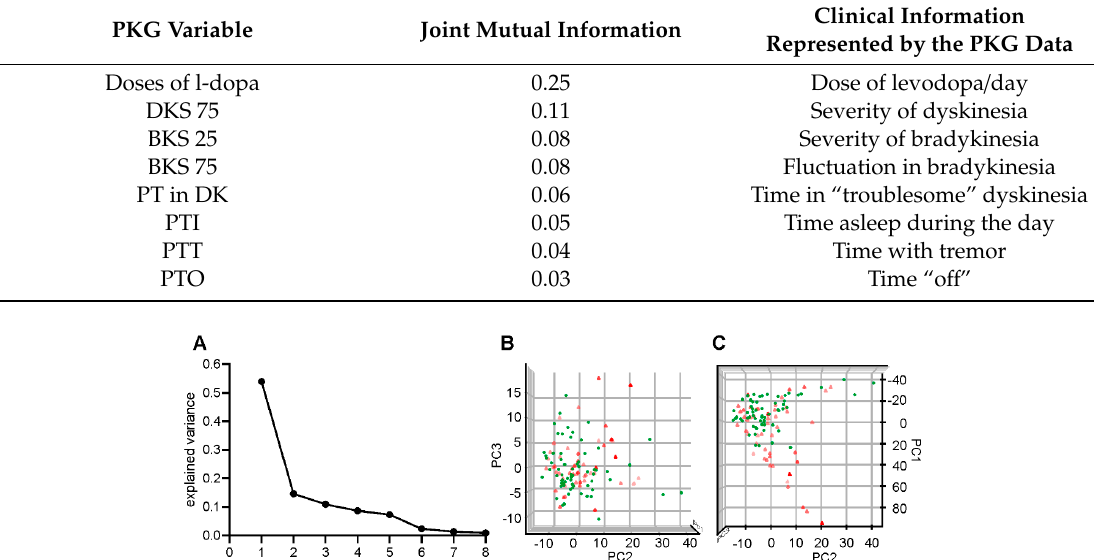
Table 2. The incremental joint mutual information of PKG variables with CP and CN labels. PKG Variable Joint Mutual Information Clinical Information Represented by the PKG Data Doses of l-dopa 0.25 Dose of levodopa/day DKS 75 0.11 Severity of dyskinesia 0.08 Fluctuation in bradykinesia BKS 25 0.08 Severity of bradykinesia PT in DK 0.06 Time in “troublesome” dyskinesia PTI 0.05 Time asleep during the day PTT 0.04 Time with tremor PTO 0.03 Time “o ff ”